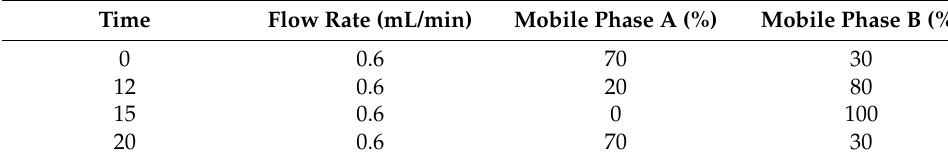
Table 1. Gradient mobile phase for Ultra Performance Liquid Chromatograph.